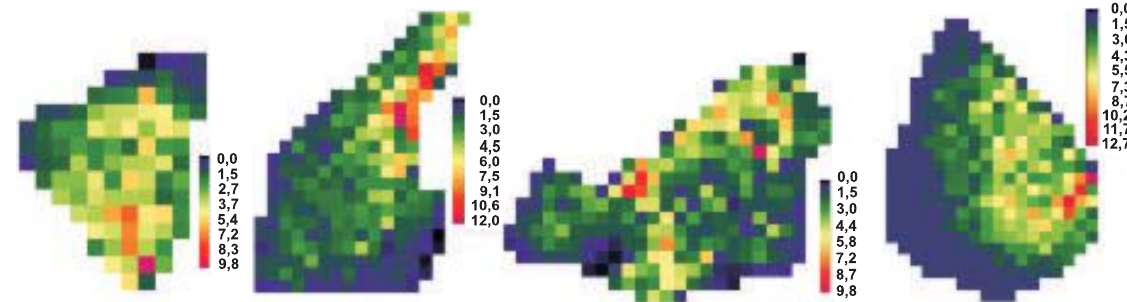
Figura 3. Fator LS calculado pelo método de Moore & Burch (1986a) para as quatro